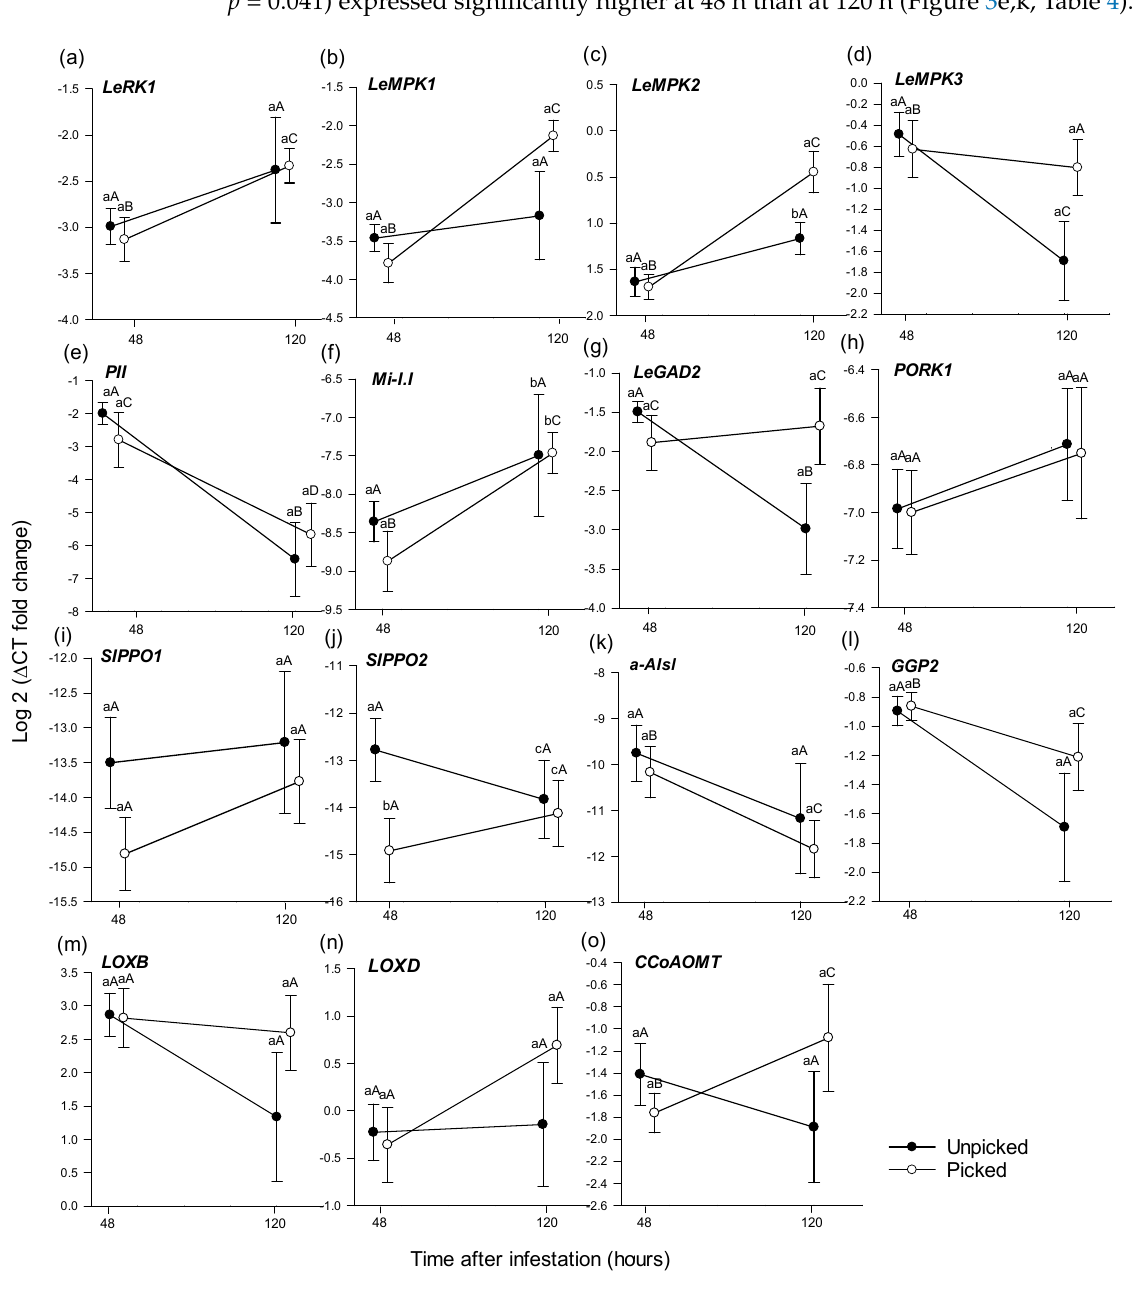
Figure 3. Mean ( ± 1 SE) relative expression (log 2 of 2 − ∆ CT ) of 15 putative induced defence genes ( a – o ), as assessed using RT-qPCR, from Roma tomato at the colour-break ripening stage infested by larvae of Bactrocera tryoni . Comparisons are of genes extracted from fruit at two time periods (48 h and 120 h) after larval inoculation and of two picking states (unpicked and picked); n = 10 fruit for each time point and status. Lower-case letters reflect significance or otherwise in the comparison across picking status within a time point; upper-case letters reflect significance or otherwise in the comparison within picking status across time points.